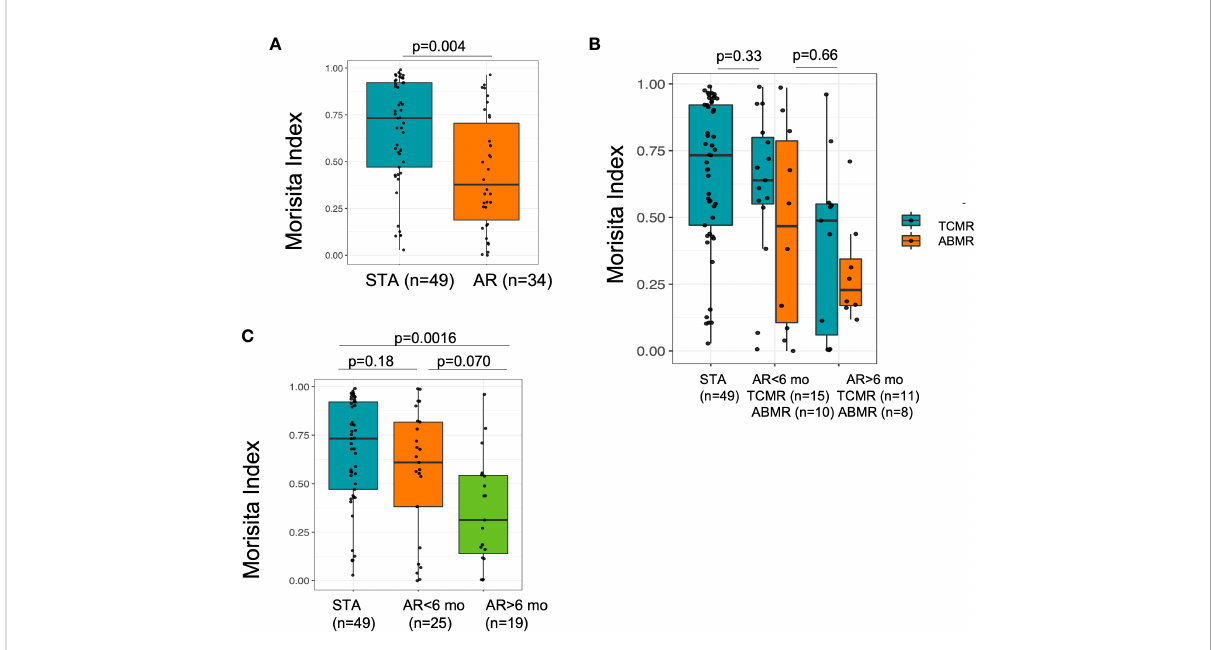
FIGURE 4 Morisita Index which measures similarity based on the number of shared sequences between two populations as well as how well represented those overlapping sequences are within the two populations was low in AR and in antibody mediated rejection. (A) The T cell repertoire turnover is higher (with low Morisita Index) in patients with AR at > 6 mo post transplantation. (B) The turnover of TCR was more pronounced in ABMR compared with patients with STA and TCMR. (C) There was a greater repertoire turnover at AR event compared to STA at matching post- tx timepoint at 6